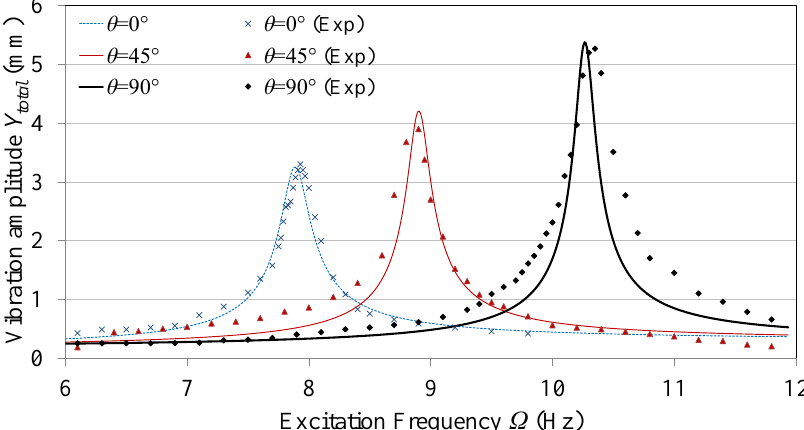
Figure 4. Tip amplitude frequency